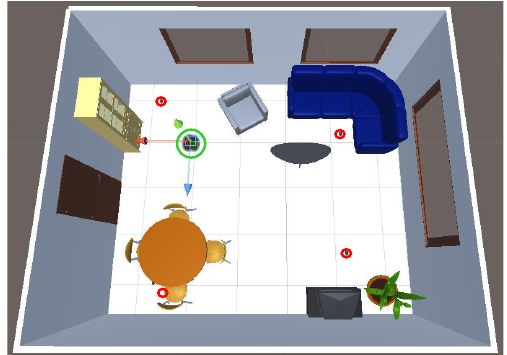
Figure A1. An example of a room where the subject performs the